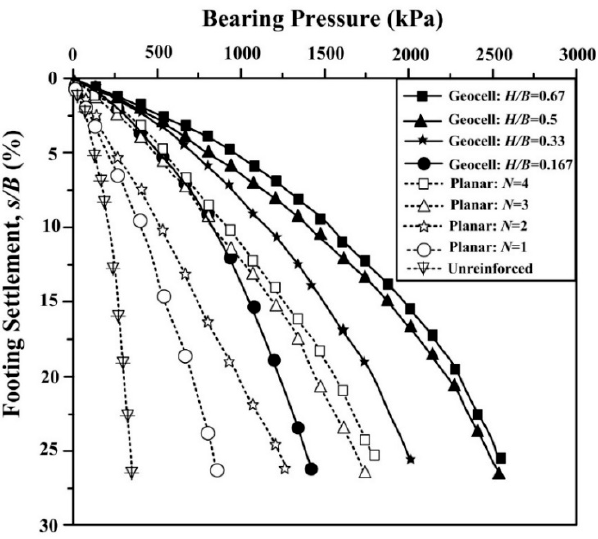
Figure 11. Variation in applied pressure and settlement for medium width coir geotextile in both planar and geocell forms (b g /B = 3.2 and b p / B = 3.75) (Lal et al. [34]).